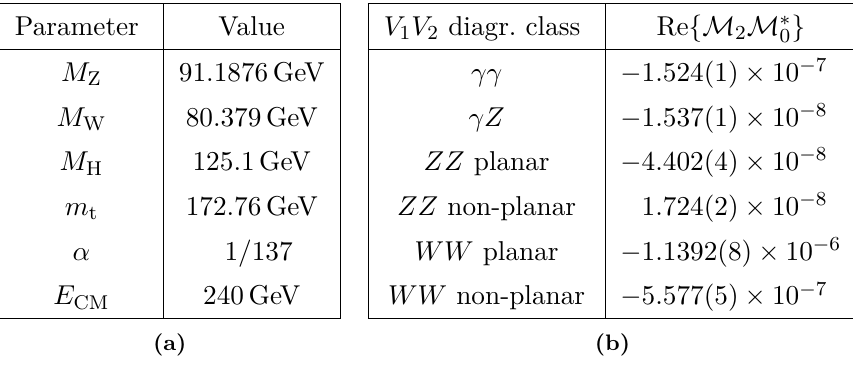
Table 1. (a) Input values used for the numerical examples. (b) Results for different classes of two-loop box diagrams, distinguished by topology and internal gauge-boson species, for scattering angle θ = π/ 2 . The numbers in brackets indicate an estimate of the intrinsic uncertainty in the last shown digit (see text for more